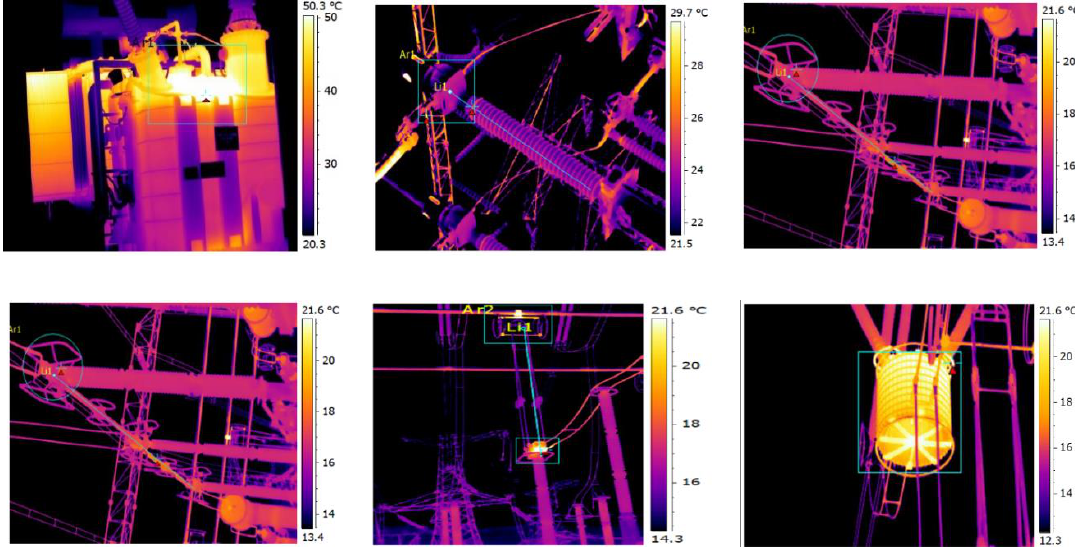
Figure 7. Database of original infrared images of high voltage electrical